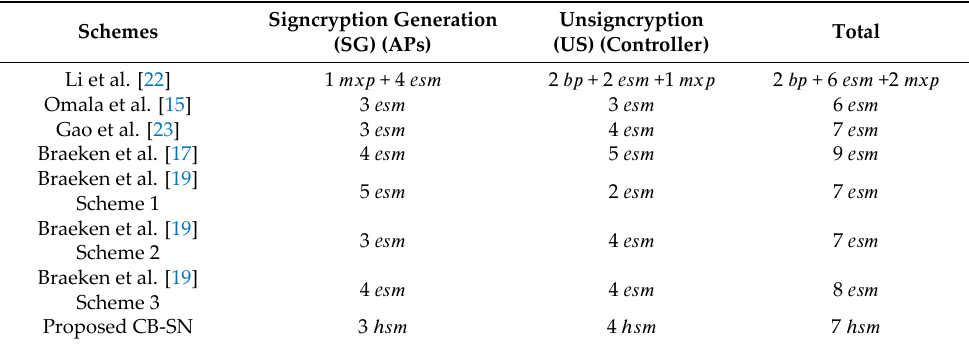
Table 3. Comparison with respect to major operations.